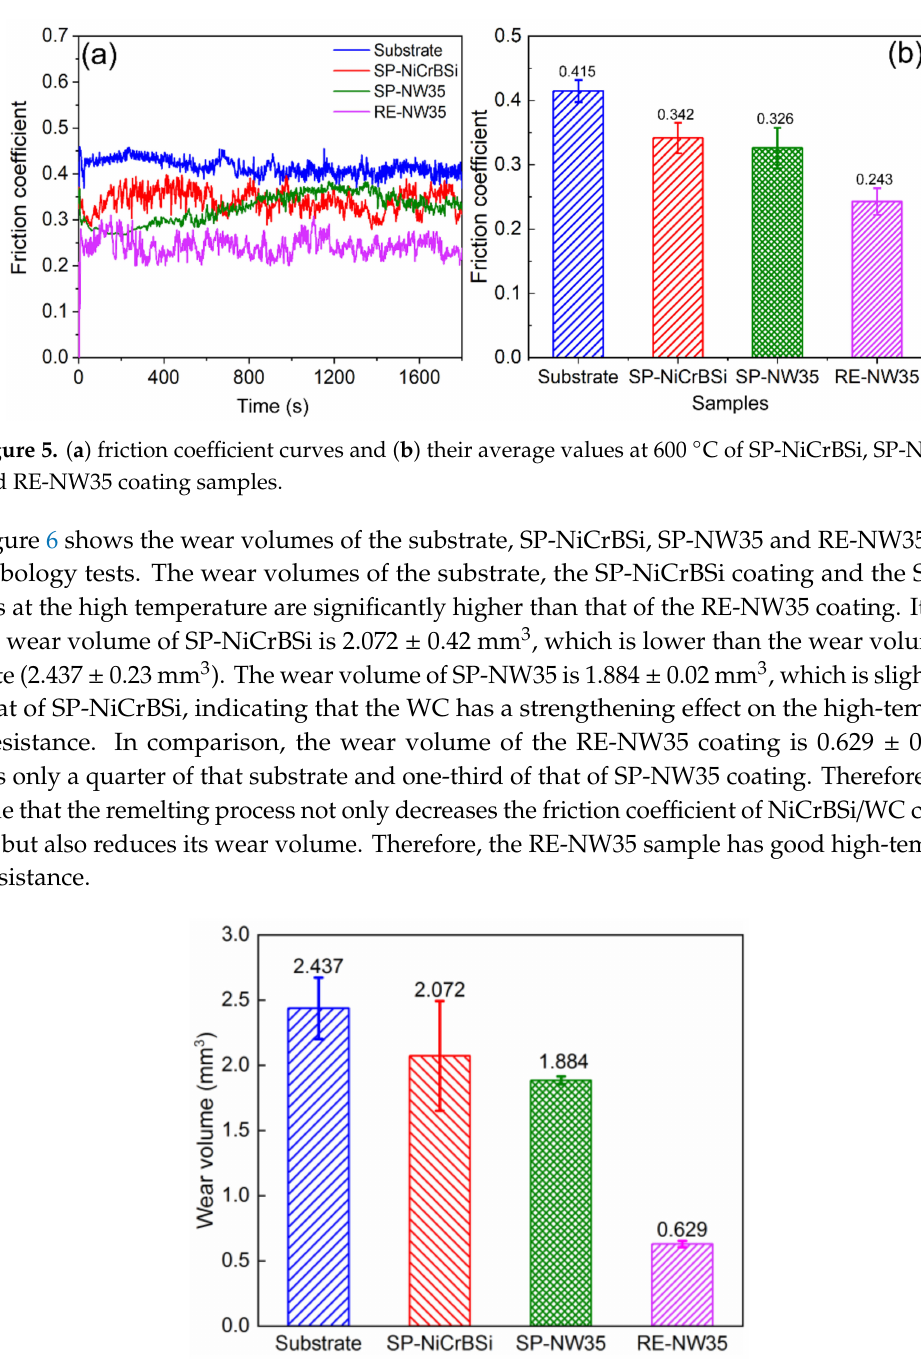
Figure 6. Wear volumes of the substrate, the SP-NiCrBSi, SP-NW35 and RE-NW35 coatings at 600 ◦